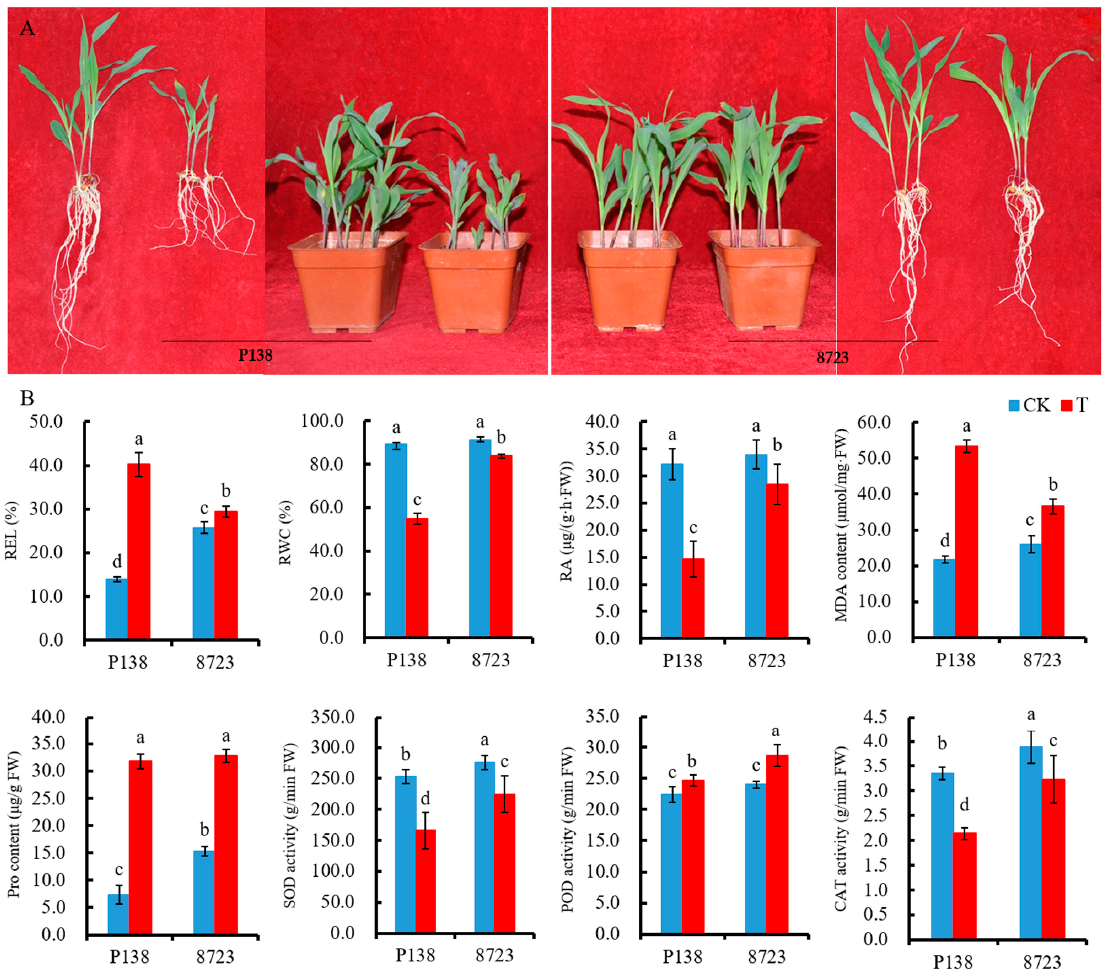
Figure 1. Seedling plant growth and physiological indexes ( A ) Seedling plant growth of P138 and 8723 under control conditions and 180 mM NaCl stress; ( B ) Seedling physiological indexes of P138 and 8723 under control conditions and 180 mM NaCl stress. Data are presented as the mean ± standard deviation. Lowercase letters indicate a significant di ff erence at the 5% level. Abbreviations: CK: